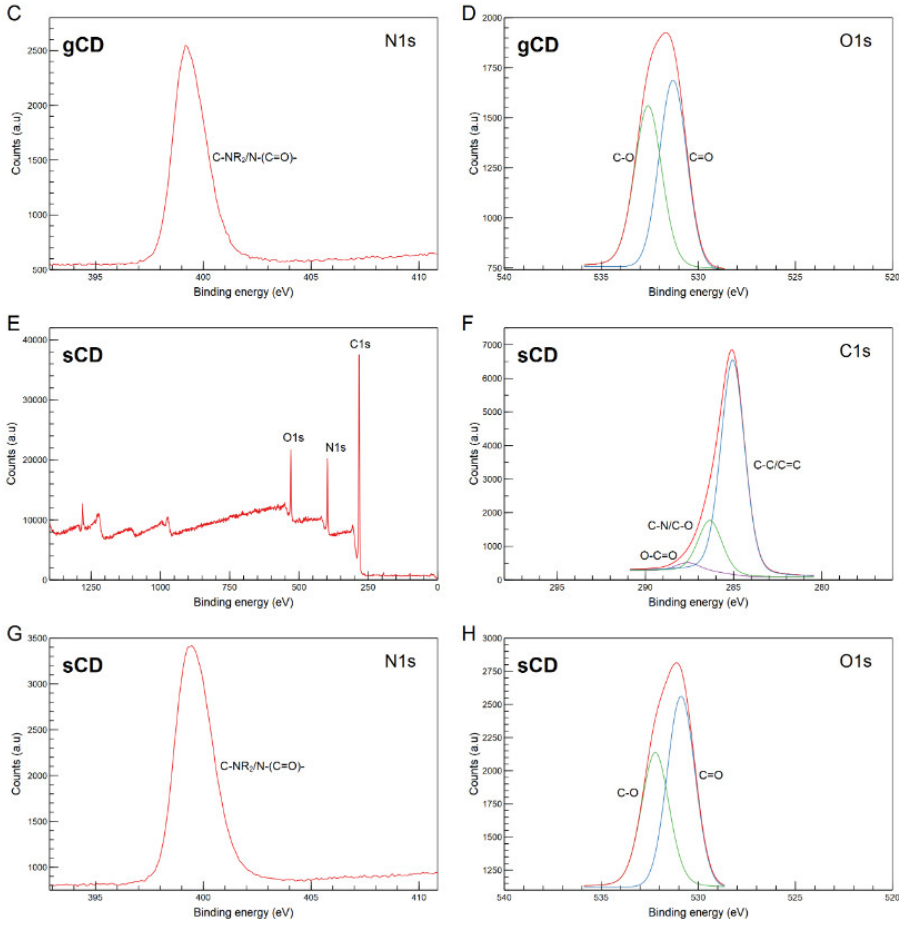
Figure 2. XPS spectra of the respective gCD and sCD. Survey spectra ( A , E ), and high-resolution deconvoluted spectra for C1s regions ( B , F ), N1s regions, and ( C , G ) and O1s regions ( D , H ).